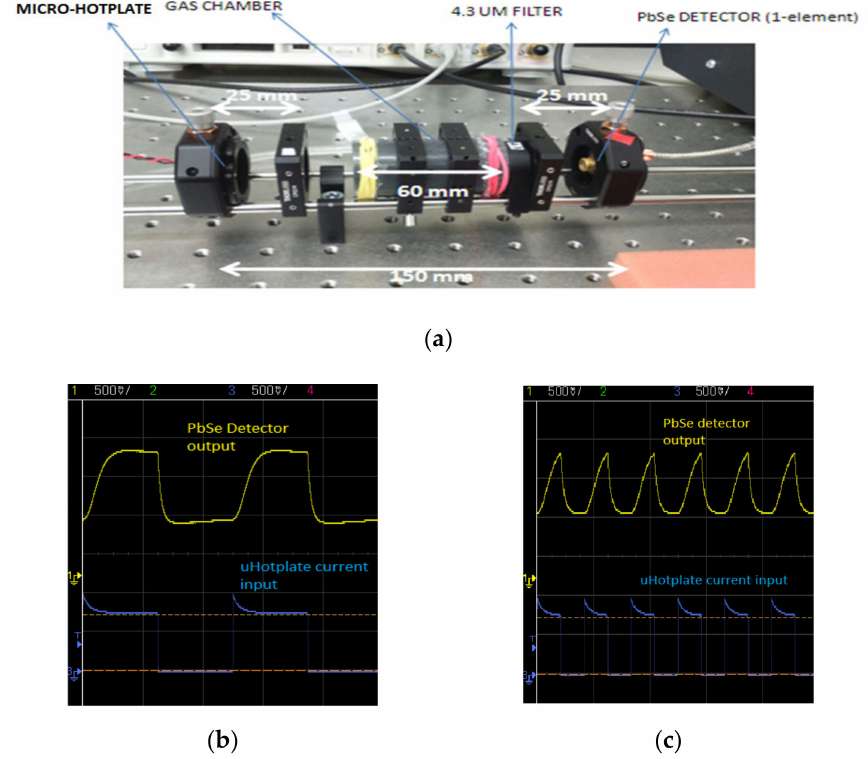
Figure 4. ( a ) Demonstrator setup for gas detection with 25 mm optical lenses, ( b ) output with the hotplate driven with a 4 Hz square wave, and ( c ) output with hotplate driven with 12 Hz square wave.